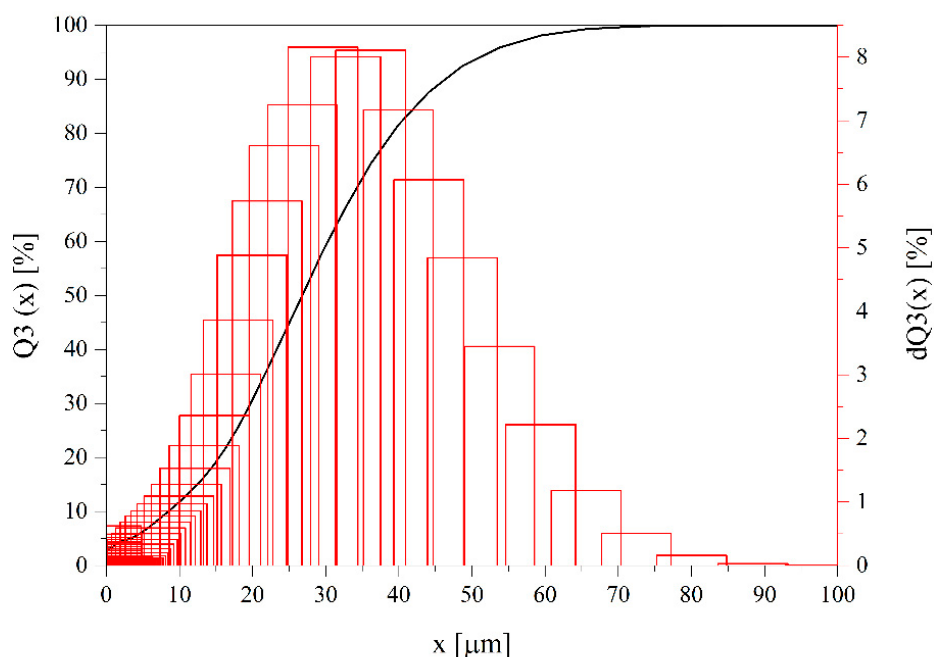
Figure 1. Particle size distribution of sunflower husk ash.